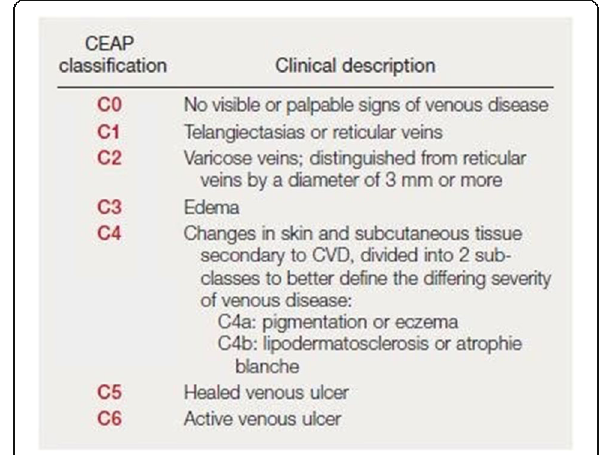
Fig. 6 The CEAP clinical classification of varicose veins